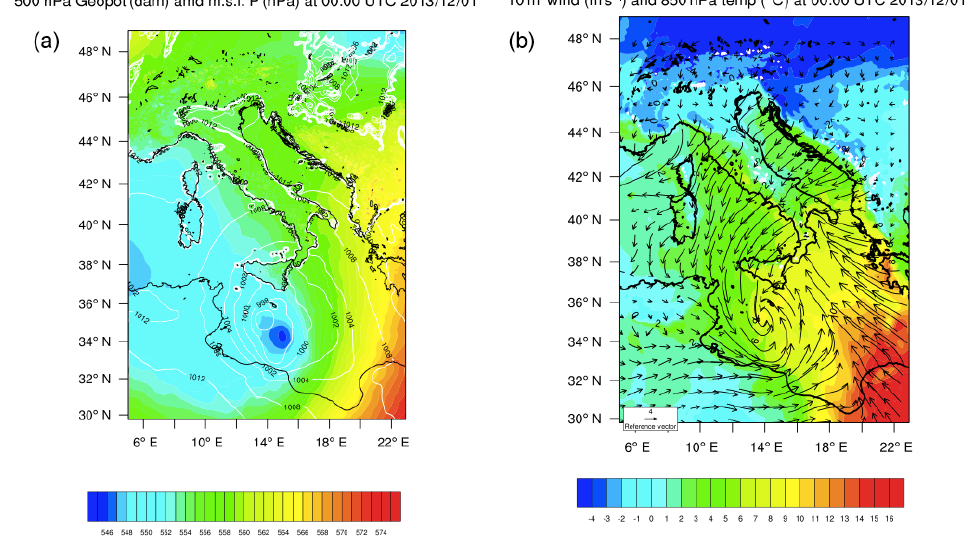
Figure 7. Mesoscale maps during the weather storm on 1 December 2013 (Event 2). (a) WRF (domain 1) geopotential height (in decameter; colours) at 500hPa and mean sea level pressure (in hPa, white lines). (b) WRF (domain 1) 850hPa temperature (in C, colours) and 10m wind (in ms − 1 , black arrows)